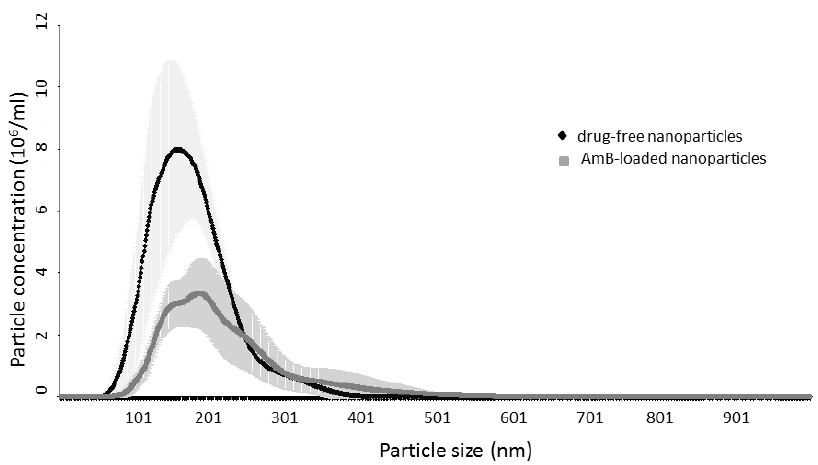
Figure 3. Size distribution profiles from NTA for drug-free and AmB-loaded solid lipid nanoparticles ( n = 3).